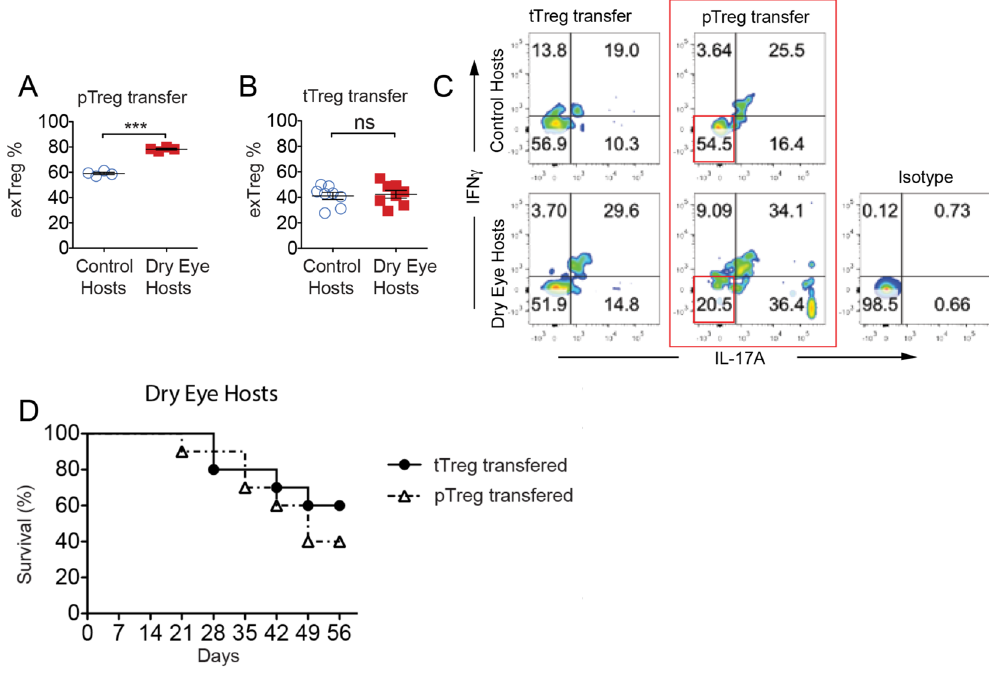
Figure 3. pTregs show a higher susceptibility to convert into exFoxp3 cells after transfer into dry eye hosts. pTregs (CD4 + CD25 + Nrp-1 − ) and tTregs (CD4 + CD25 + Nrp-1 + ) from transgenic dry eye disease (DED) mice (Foxp3-GFP × R26-RFP) were adoptively transferred into control and DED transplant recipients. ( A and B ) Draining lymph nodes were harvested at day 14 post-transplantation. Single cell suspensions were analyzed by flow cytometry. Frequencies of exFoxp3 cells (GFP − RFP + ) from control and DED hosts that received ( A ) pTregs (59.02 ± 0.92% vs. 78.26 ± 0.69%, n = 4, *** p < 0.0001 unpaired two-tailed Student’s t test) or ( B ) tTregs was assessed. ( C ) Representative flow cytometry plots showing frequencies of IL-17 and IFN γ -expressing exFoxp3 cells in draining lymph nodes from control and dry eye hosts. ( D ) Nrp1 + tTregs or Nrp1 − pTregs from